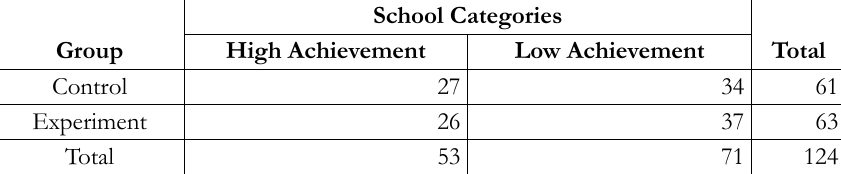
Table 1. The Distribution of Sample